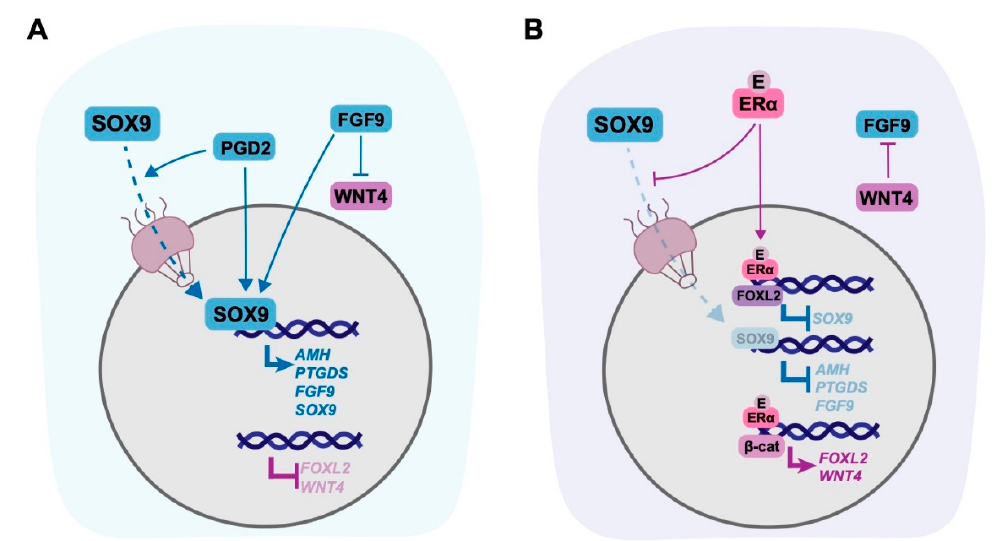
Figure 4. Model for the regulation of gonadal genes and SOX9 subcellular localisation by oestrogen in Sertoli cells. ( A ) In a normal Sertoli cell SOX9 increases expression of itself and its downstream targets AMH , FGF9 , and PTGDS by translocating from the cytoplasm to the nucleus. PGD2 facilitates the nuclear entry of SOX9, while FGF9 inhibits WNT4 and there is no expression of FOXL2 . ( B ) Exogenous oestrogen (E) blocks SOX9 nuclear entry, preventing activation of SOX9 downstream targets. Activated oestrogen receptors (ER α ) and FOXL2 repress SOX9 transcription and, together with β -catenin, promote expression of WNT4 and FOXL2 . WNT4 subsequently inhibits FGF9.